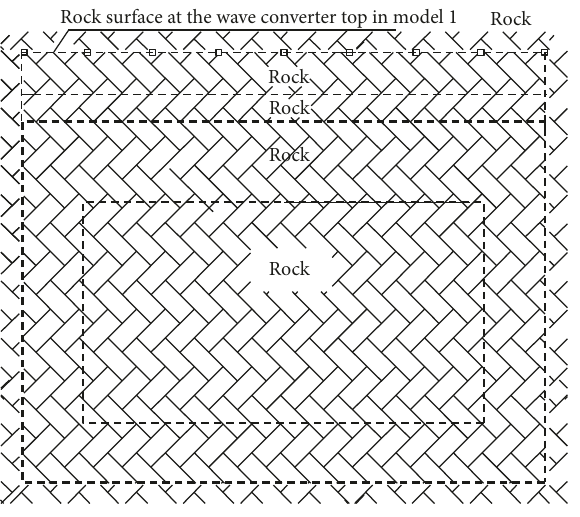
Figure 5: Schematic of model 2.